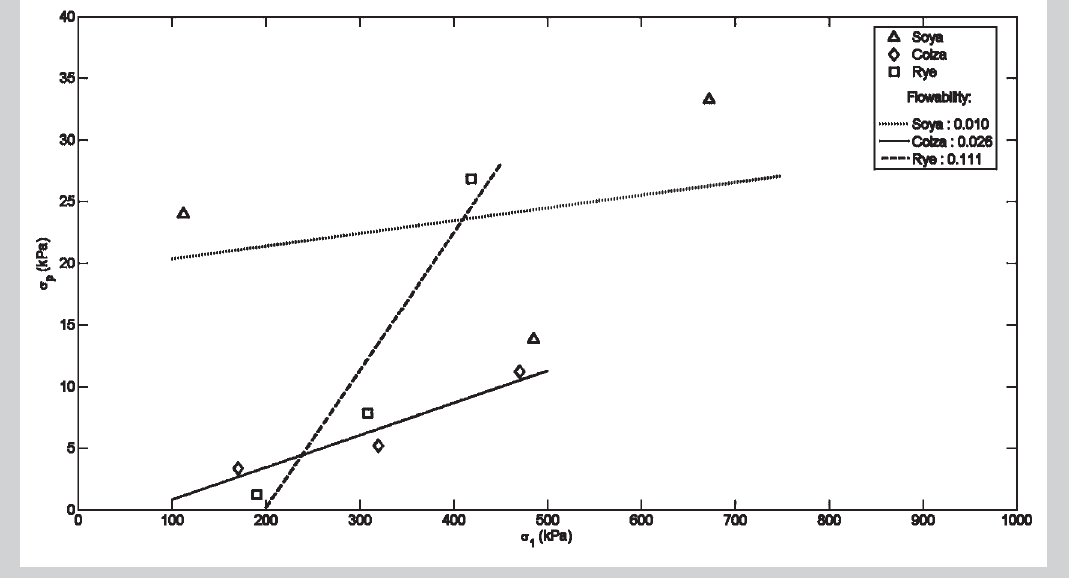
Figure 5: Flow functions of the granu- lar materials